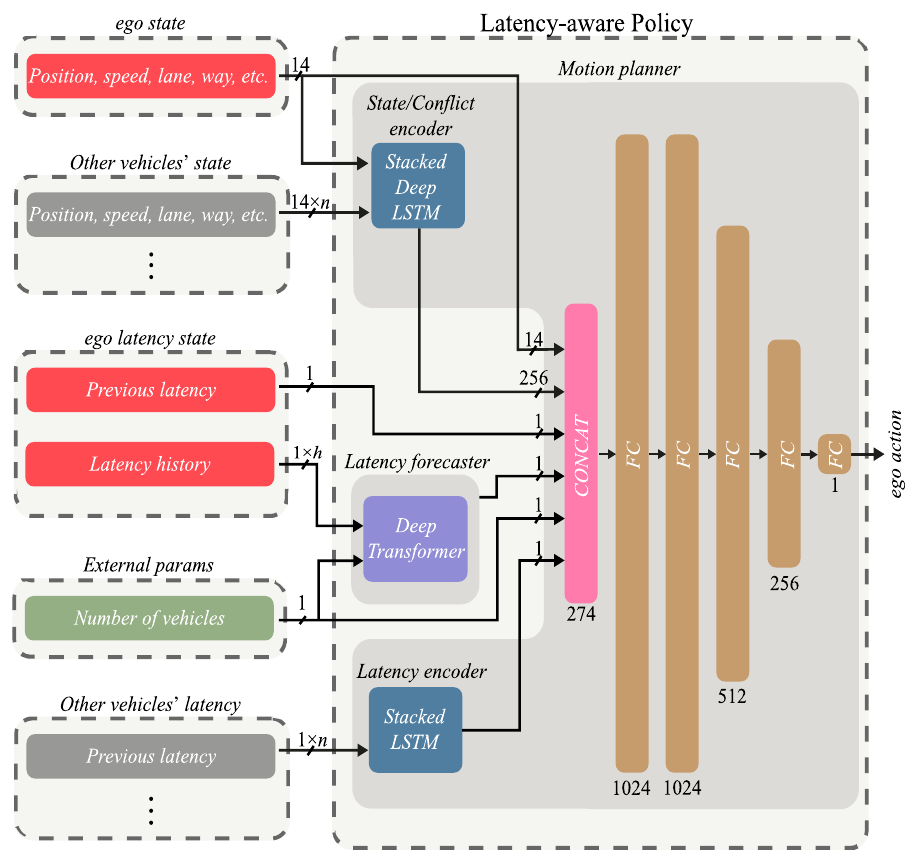
Figure 2. AIM5LA architecture with latency forecaster module based on Deep Transformer model and Latency encoder based on Stacked LSTM network.